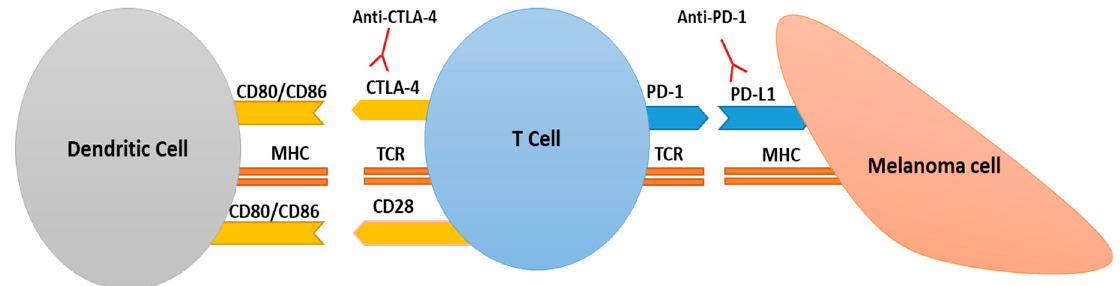
Figure 1. CTLA-4- and PD-1-based immunosuppression. Full activation of the T cell requires the interaction between the T lymphocyte receptor (TCR) and the peptide–MHC complex present on the dendritic or cancer cell as well as the binding of co-stimulatory molecules found on T cells (e.g., CD28) to their receptors localized on dendritic cells (DCs) (e.g., CD80 and CD86). CTLA-4 competes with the CD28 receptor for binding to CD80 / CD86 molecules and negatively stimulates these cells, leading to their inactivation. PD-1 binds to PD-L1 found on the surface of tumor cell and, thus,